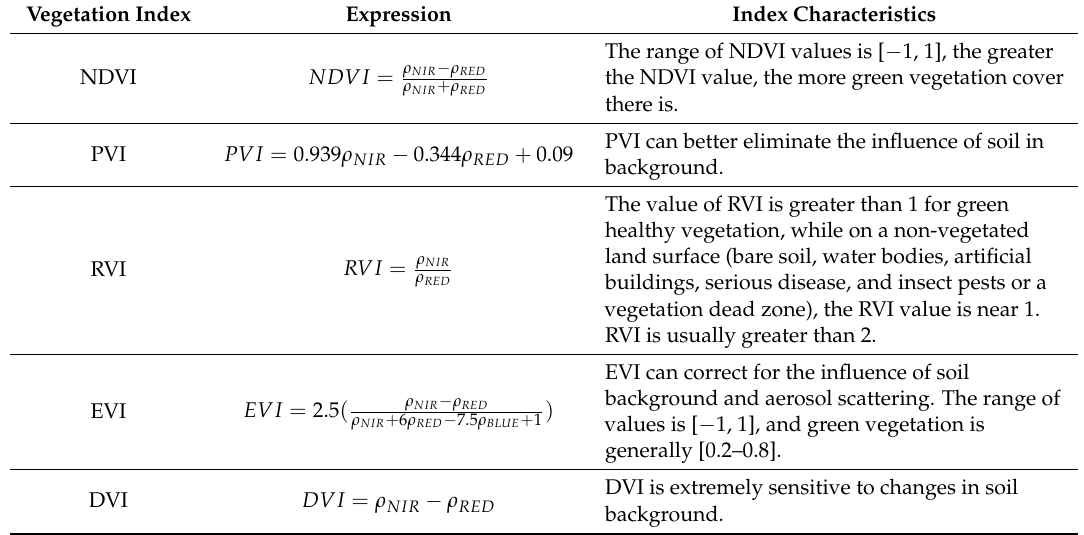
Table 1. Expression and characteristic table of vegetation index